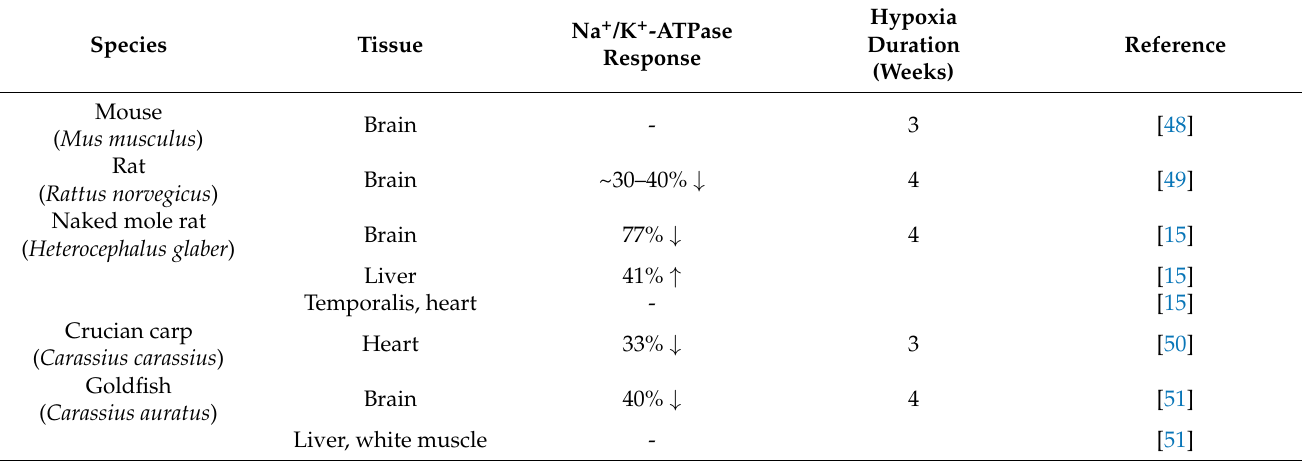
Table 1. Effects of chronic hypoxia (minimum 1 week) on the maximal activity of Na+/K+-ATPase in various